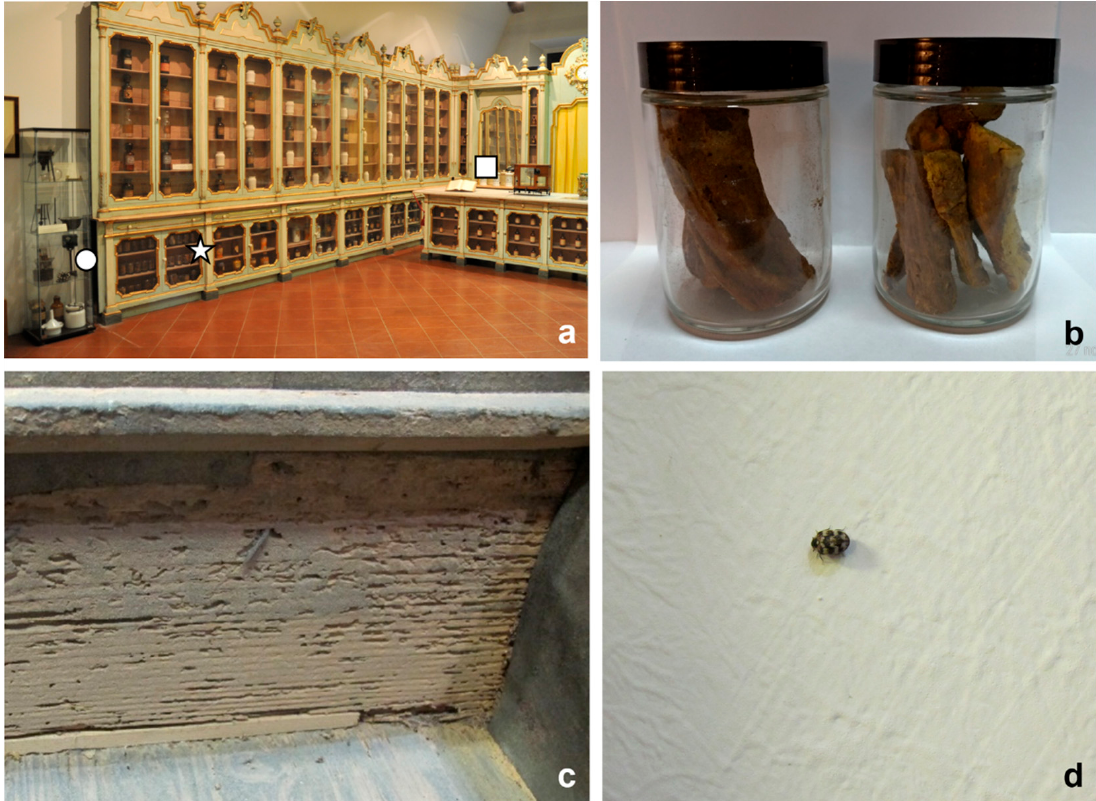
Figure 2. Analysis of insect biodeterioration in the Navarra-Bragliani Pharmacy: ( a ) points where insect samples were collected; ( b ) materials contained in two pharmacy jars found attacked by Stegobium paniceum . The position of the jars is indicated by a star in Figure 2a; ( c ) detail of the drawer indicated by a square in Figure 2a, showing damages by Lyctus brunneus ; ( d ) live individual of Anthrenus verbasci walking in the position indicated by a circle in Figure 2a.